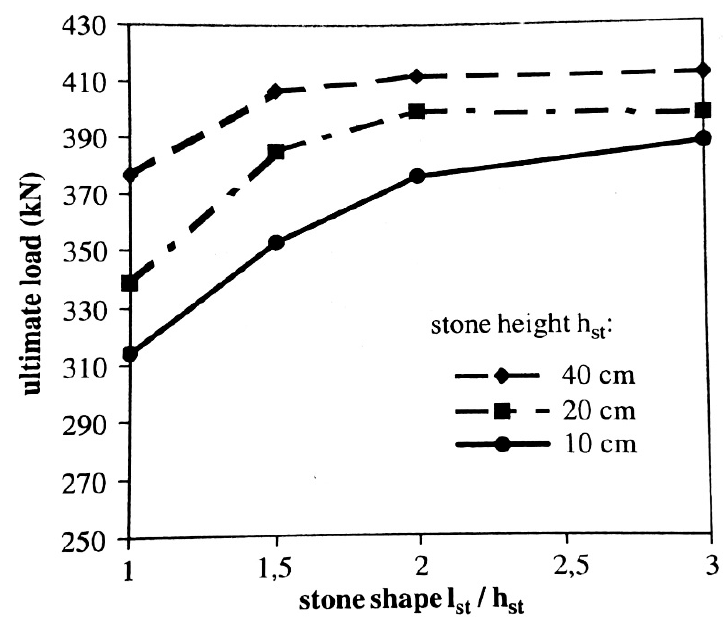
Figure 4. Ultimate loads for different variations of stone height (hst) and of stone unit length (lst) (Schlegel and Rautenstrauch, 2004 [102]).